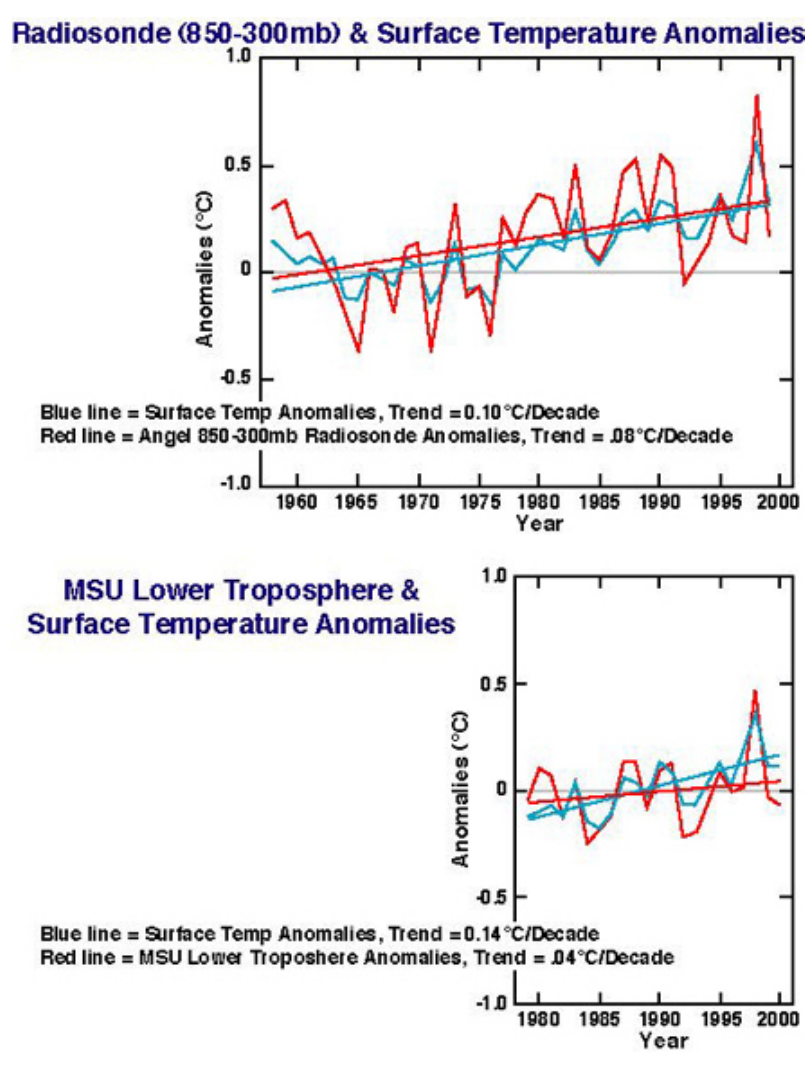
FIGURE 5. Comparison of yearly temperature anomalies at surface (green) and mid-troposphere (red). (a) Surface and satellite MSU 2LT for mid-troposphere (note disagreement beginning after 1991). (b) Surface and radiosonde (balloon-borne) for mid-troposphere; same effective altitude range as detected by satellites. Note general agreement of trends over this longer period. Satellite and sonde agree after